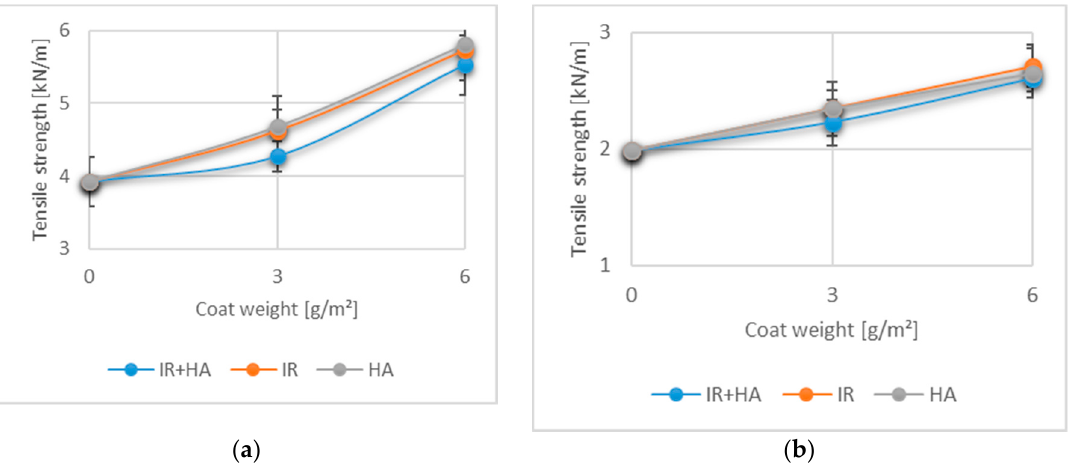
Figure 3. Tensile strength (TS) of paper coated with 3 g/m 2 (1 layer) and 6 g/m 2 (2 layers) of chitosan: ( a ) TI for machine direction (MD); ( b ) TI for cross direction (CD). ( n = 15).